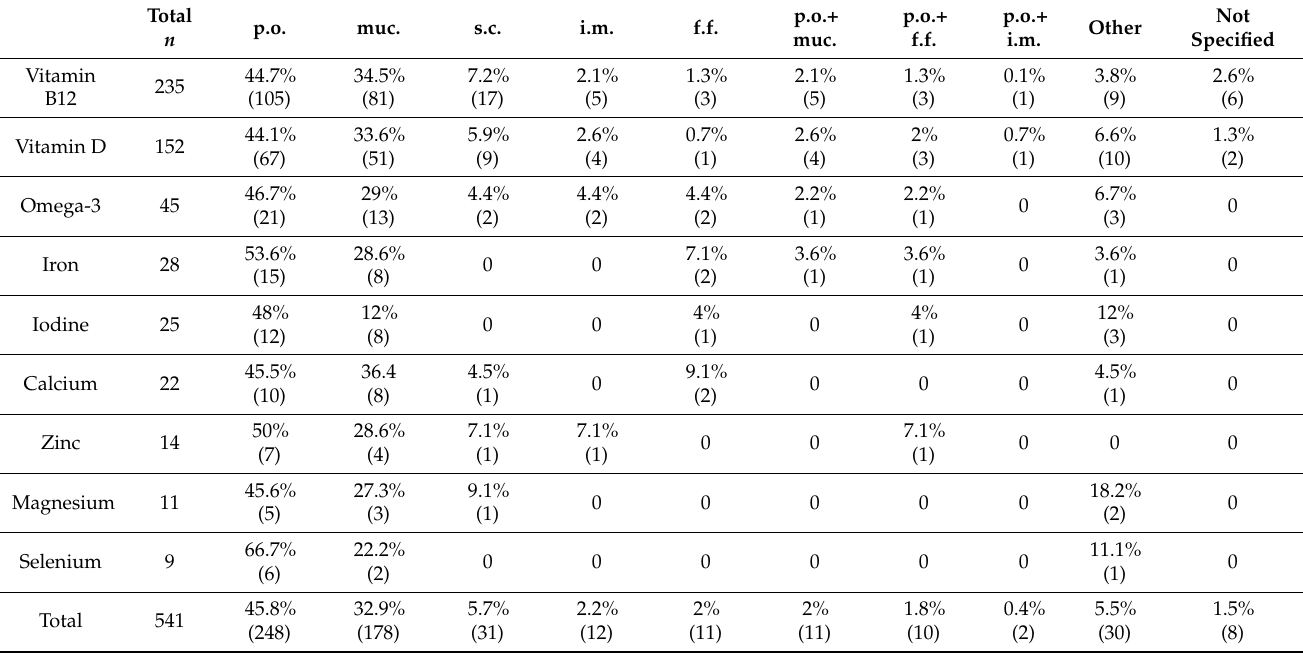
Table 3. Application types of the most frequently mentioned supplements among vegans, in percent ( n in